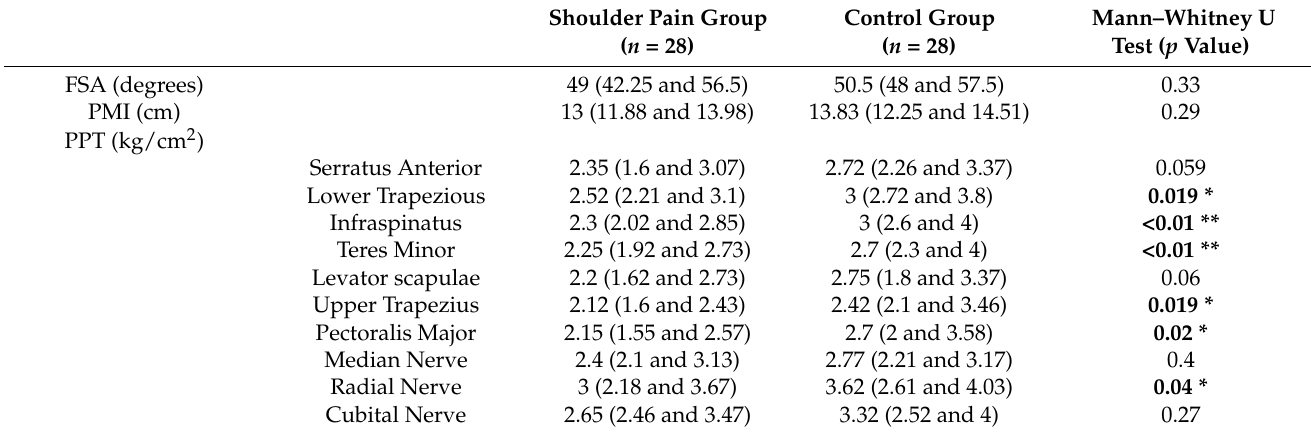
Table 2. Measurements of the study. Values are median (first and third quartiles) and n